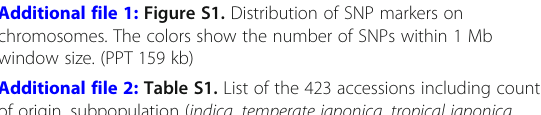
window size. (PPT 159 kb)